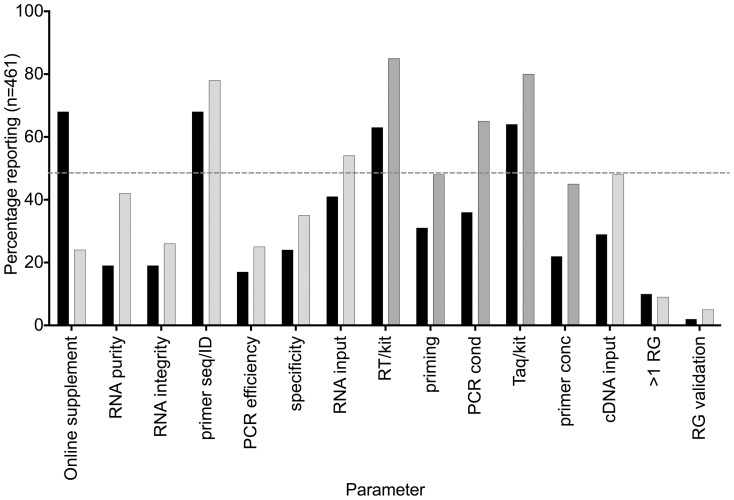
Comparison of online supplement utilization and MIQE compliance between publications with IF<5 (grey) and those ≥5 (black).Both datasets passed the D'Agostino & Pearson and Shapiro&Wilks normality tests, hence the parametric paired t-test was used for data analysis). The hatched grey line indicates 50% compliance.